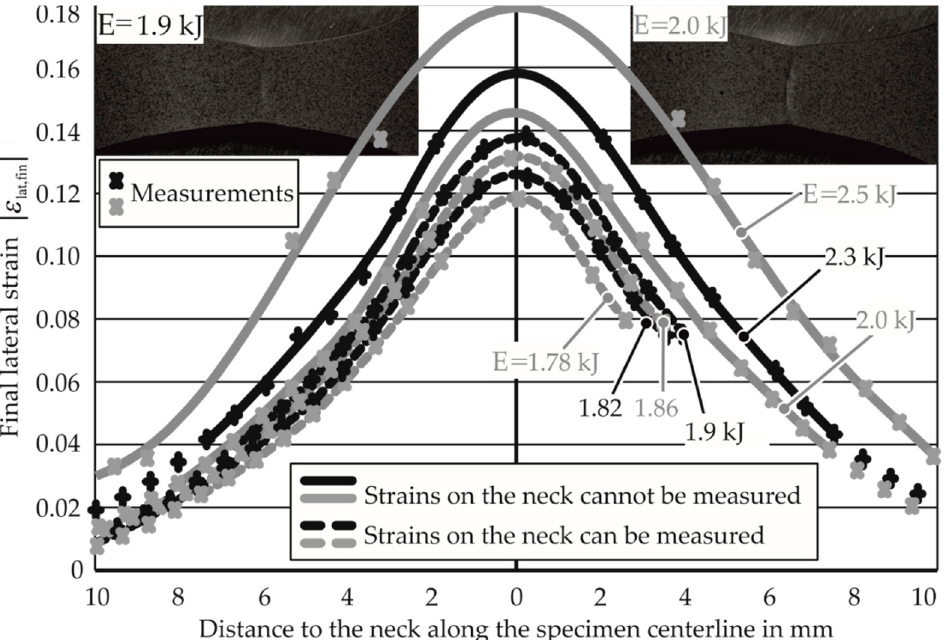
Figure 14. Curve fitting to the measured strains along the centerline. Each cross represents a measurement. E denotes input energy. Material: AA1050A, 1 mm thick, under uniaxial tension.